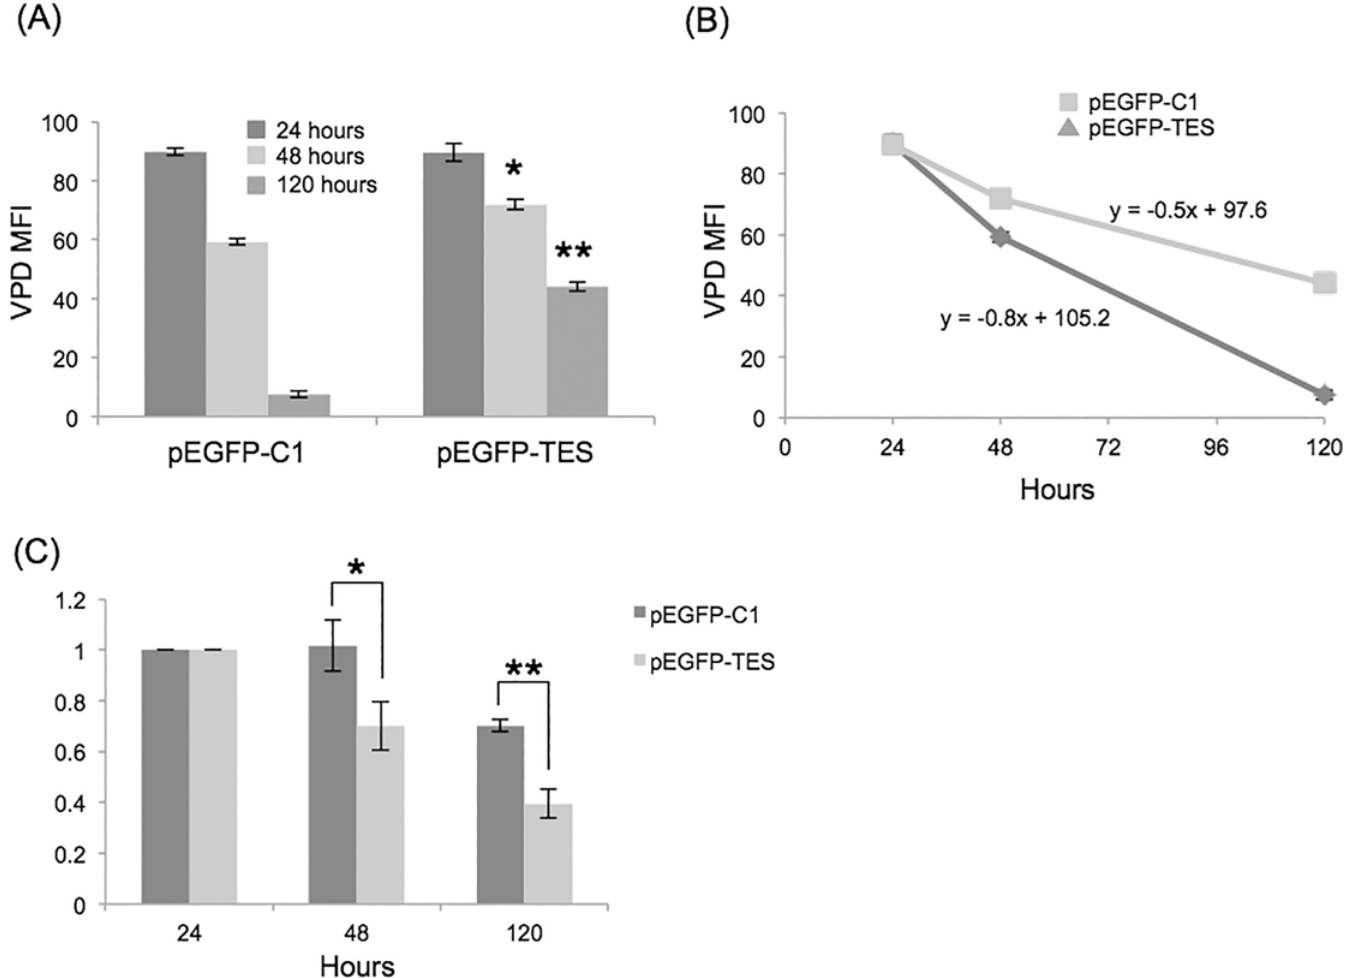
Fig 5. Reduced proliferation of pEGFP-TES transfected NALM6 cells. (A) Average VPD MFI for GFP-positive, transfected cells at 24, 48 and 120 hours were compared (n = 3). pEGFP-TES transfected NALM6 cells have higher average VPD MFI than GFP-negative (data not shown) or control transfected NALM6 cells, indicating that these cells have undergone fewer cell divisions (unpaired, two-tailed Student ’ s T-test; * p = 0.003, ** p < 0.0001). (B) Proliferation rates of GFP-positive, transfected cells clearly showing reduced proliferation of pEGFP-TES transfected compared to control-transfected cells (line equations were calculated using MS Excel). (C) Reduction in GFP-positive cells over time, calculated relative to 24 hours. Significance was determined between control- and EGFP-TES-transfected cell proportions at 48 ( * p = 0.07) and 120 hours ( ** p = 0.009)(unpaired, two-tailed Student ’ s